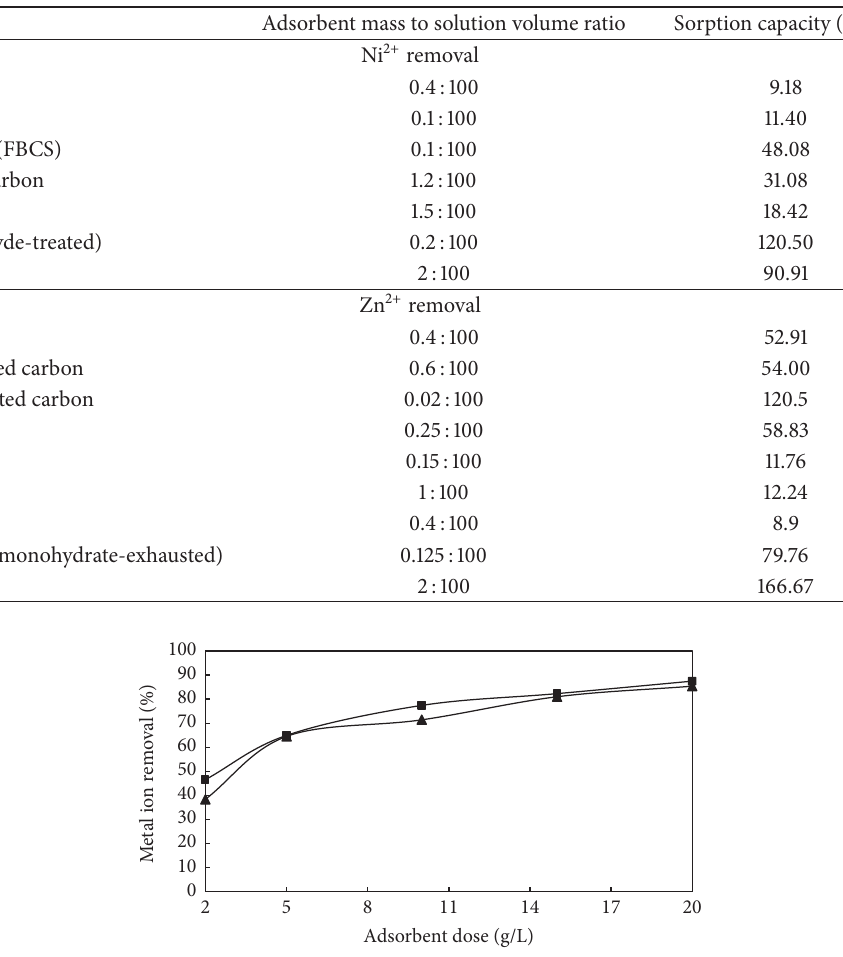
adsorbent compared to other adsorbents for remediation of aquatic